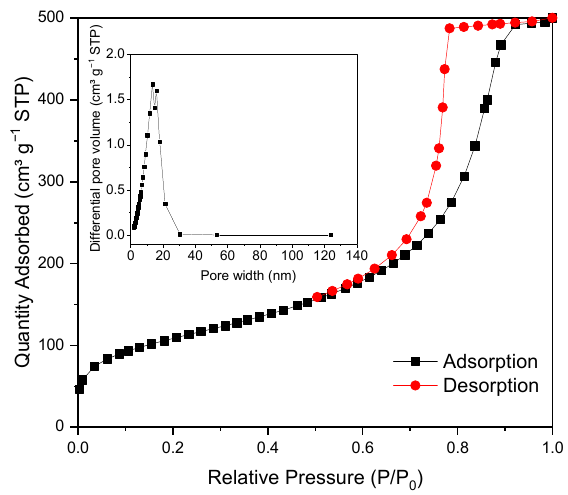
Figure 2. Nitrogen adsorption/desorption isotherm of CXTi synthesised in this study. High adsorbent loading appears to reduce adsorption performance, while low adsor- bent loading results in fewer pollutant molecules interacting with the active sites on the adsorbent; hence, the amount of adsorbent used is crucial in determining the ultimate adsorption performance. The study of the effect of dosage rate of CXTi on adsorption per- formance was performed at an initial concentration of 100 mg L − 1 of MB (Figure 3a). It was observed that the amount of MB adsorbed increased rapidly with increasing adsorbent dose, from 0.005 to 0.01 g, tested against 25 mL of MB solution. This is attributed to the large surface area, mesoporous character and availability of vacant adsorptive sites asso- ciated with the CXTi sorbent. Further increase in adsorbent dose, up to 0.10 g, showed no significant increase in removal of MB. At this point, the concentration of adsorbate on the surface of the adsorbent, and the adsorptive in solution, reach equilibrium. Accordingly, 0.01 g was chosen as the optimal amount of adsorbent per 25 mL to conduct the following adsorption experiments.